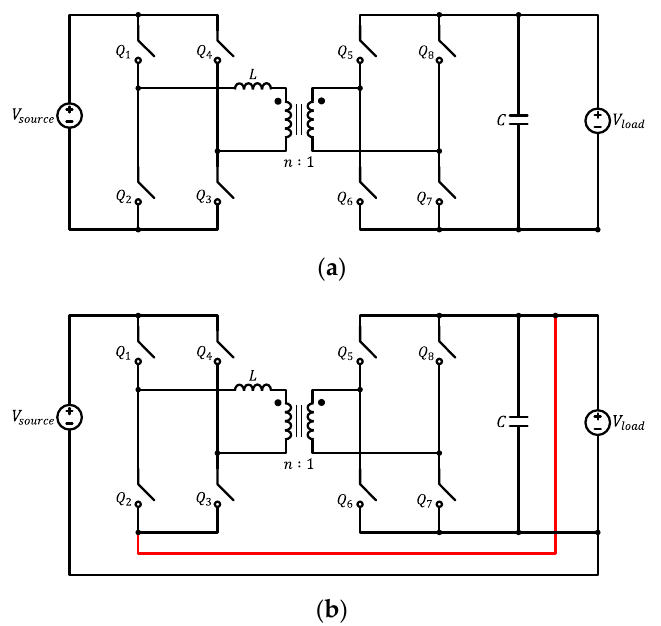
Figure 6. High level schematic of the selected solutions for the DC-DC charging unit. ( a ) DAB-FPP; ( b ) DAB-PPP.